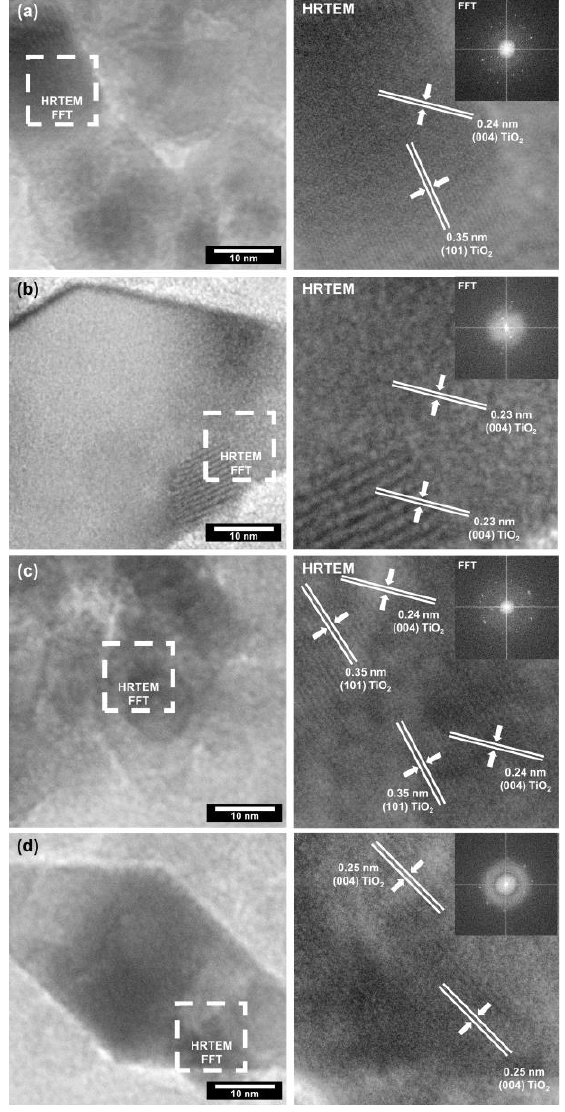
Figure 3. The HRTEM images for ( a ) TiO 2 -0.25%Eu, ( b ) TiO 2 -1.5%Eu, ( c ) TiO 2 -0.25%La and ( d ) TiO 2 -1.5%La systems.